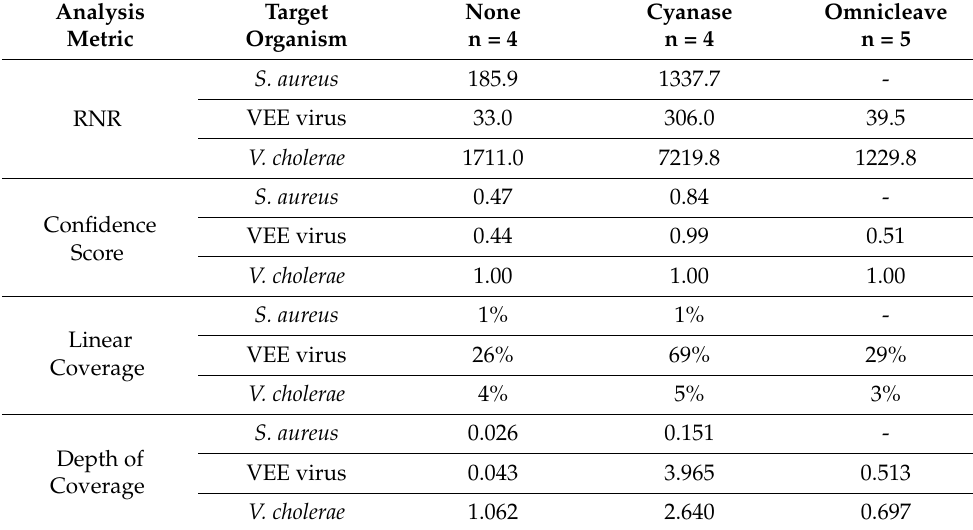
Table 2. Comparison of Pre-Lysis Host Depletion Methods. Host depletion methods were evaluated on nucleic acids extracted with the Norgen Plasma/ Serum RNA kit. Detection of target organisms was determined by comparing performance metrics; RNR, Confidence Score, Linear Coverage and Depth of Coverage. Data for Vaccinia virus was not available for this